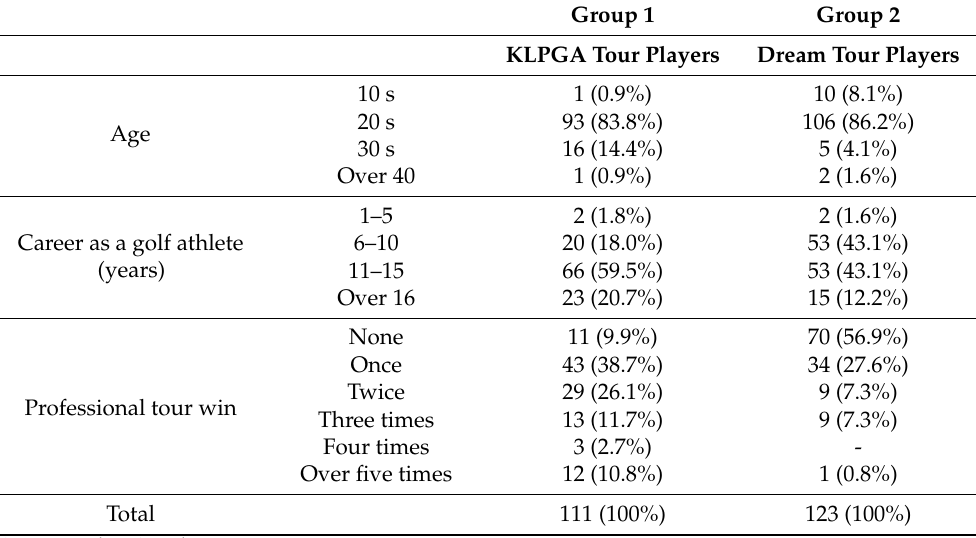
Table 1. Descriptive statistics of the